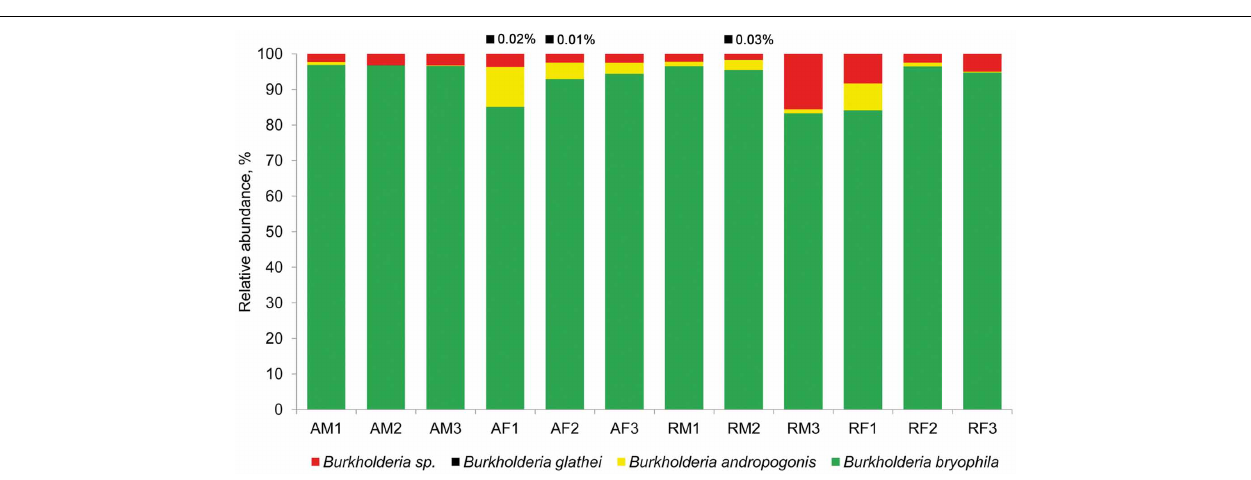
level are shown as Burkholderia sp. (red). Black squares and percentage values above the bar charts show occurrence and abundance of B. glathei . Abbreviations: A, Austria; R, Russia; F, S. fallax ; M, S. magellanicum . Arabic numerals specify different bogs in Austria and